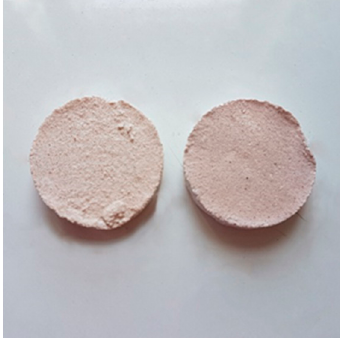
Figure 3. Type of specimens for the laboratory analyses ( a ) biscuits, ( b ) exterior wall surface.